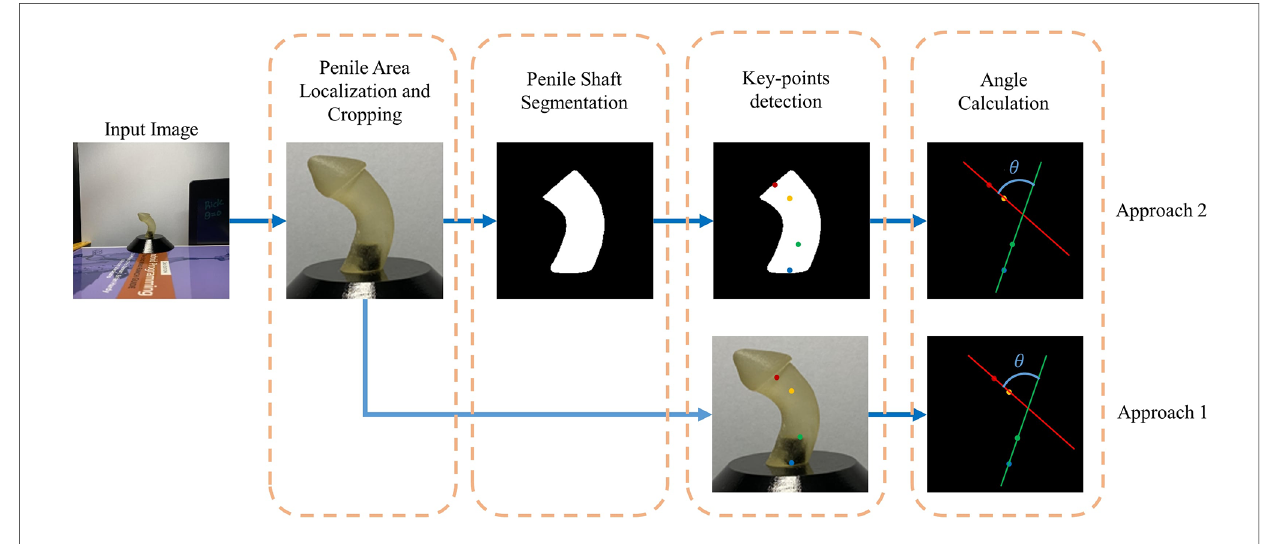
FIGURE 1 Penile angle measurement